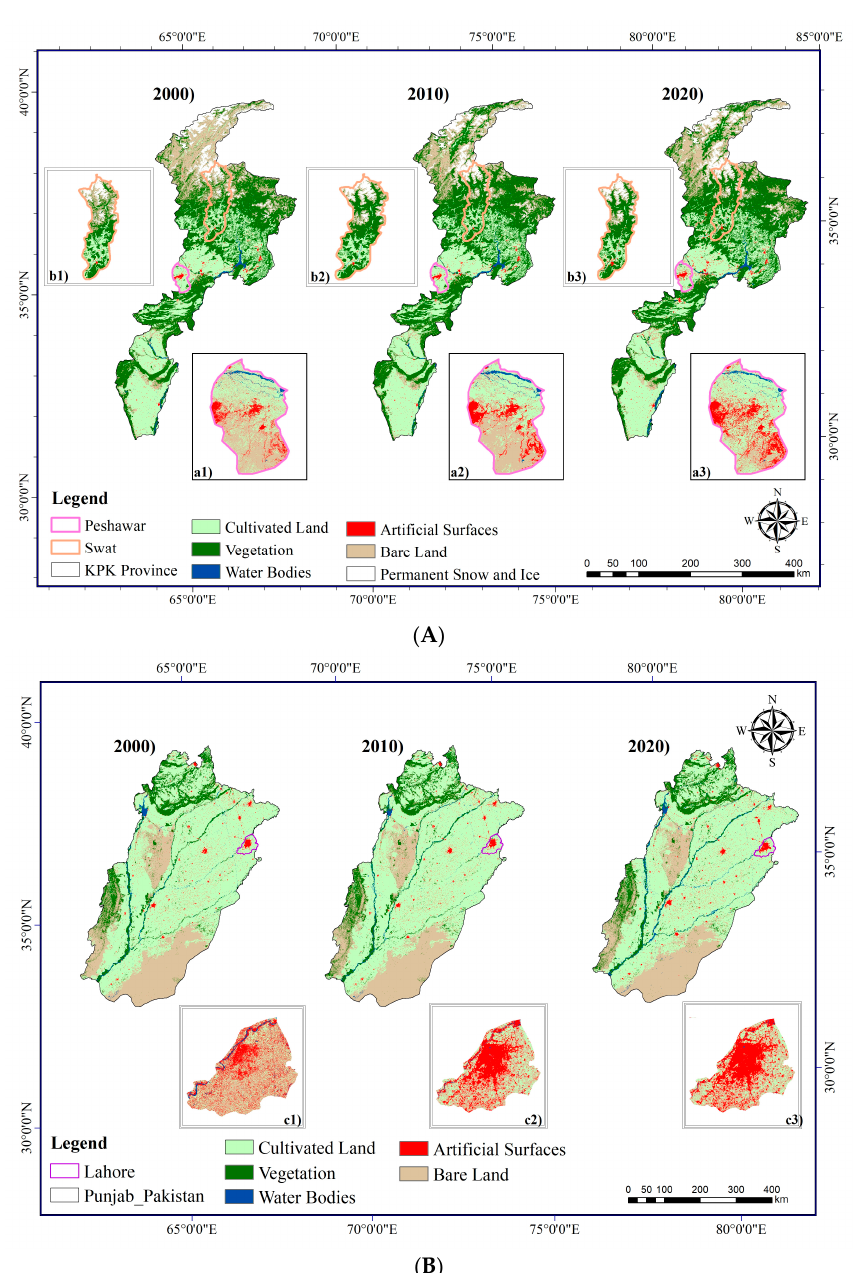
Figure 3. ( A ). Spatial patterns of land use land cover classes in KPK Province, including the sample sites (a) Peshawar (a1) 2000, (a2) 2010, and (a3) 2020; and (b) Swat (b1) 2000, (b2) 2010, and (b3) 2020. ( B ). Spatial patterns of land use land cover classes in Punjab Province, including sample site (c) Lahore (c1) 2000, (c2) 2010, and (c3) 2020.